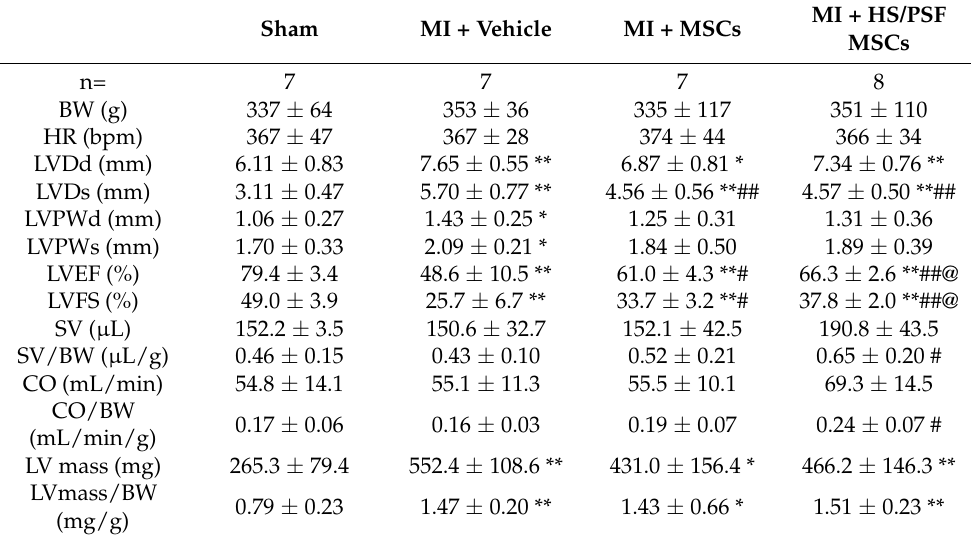
79.4 ± 3.4 48.6 ± 10.5 **